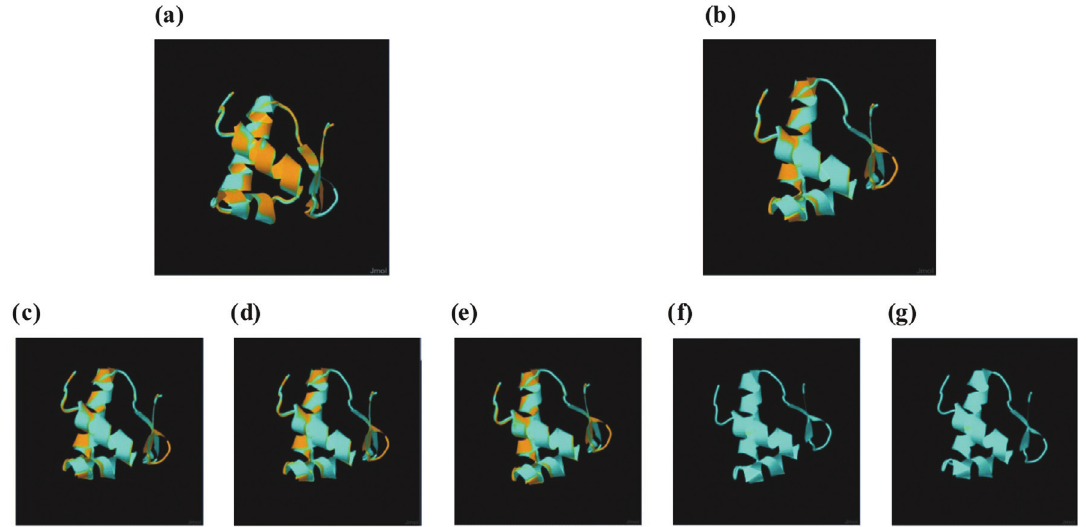
Figure 4 - Structural alignment of the NodD 1 and NodD 2 57-residue HTH domain within each genome using the Combinatorial Extension (CE) algo- rithm. The alignments are for B. diazoefficiens USDA 110 (a), B. elkanii SEMIA 587 (b), B. elkanii CCBAU 05737 (c), B. elkanii CCBAU 43297 (d), B. elkanii USDA 94 (e), B. elkanii USDA 3254 (f) and B. elkanii USDA 3259 (g). Orange residues represent NodD 1 superimposed on light-blue residues representing NodD 2